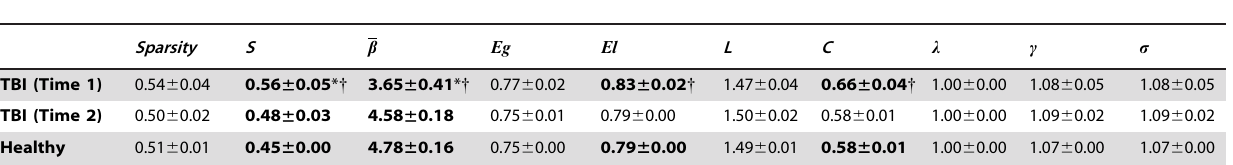
Table 1. Functional Brain Network properties of ‘‘Un-weighted’’ network with threshold value p ,